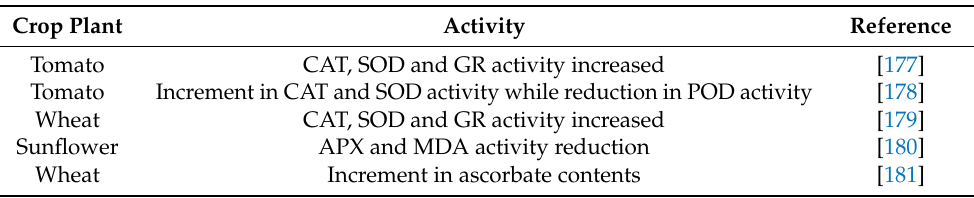
Table 5. Silicon activates the antioxidants activity and improves drought tolerance mecha- nisms